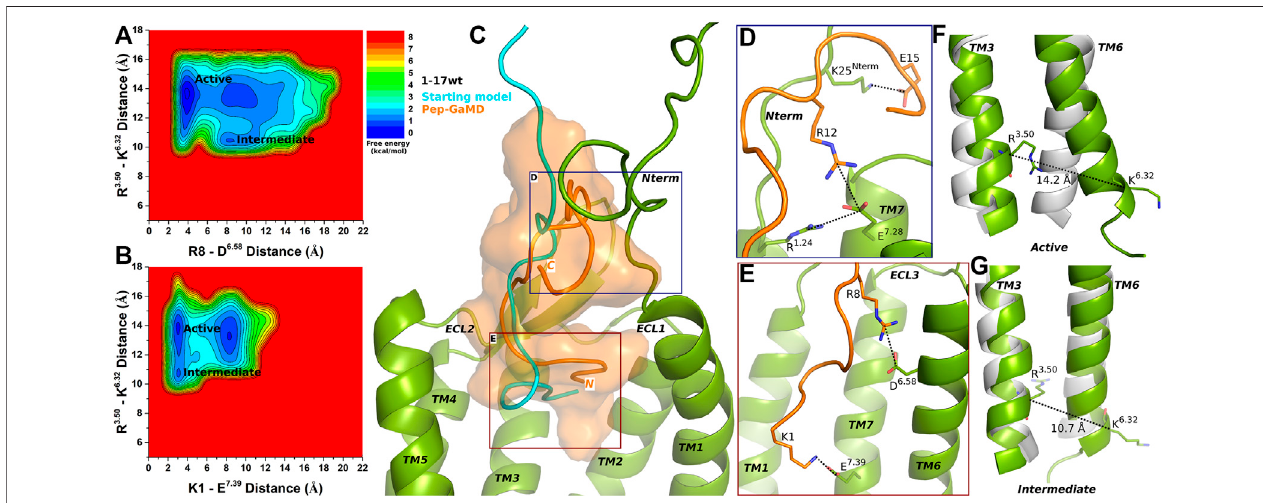
FIGURE 2 | 1 – 17 wt peptide (weak agonist) bound CXCR4 sampled Active and Intermediate low-energy states. (A – B) Free energy pro fi les of CXCR4-1 – 17wt interactions calculated regarding the distance between the C α atoms of R 3.50 and K 6.32 and (A) distance between charge centers of peptide residue R8 (the CZ atom) and receptor residue D 6.58 (the CG atom), (B) distance between charge centers of peptide residue K1 (the NZ atom) and receptor residue E 7.39 (the CD atom). (C) Comparison of the top-ranked structural cluster of the 1 – 17wt peptide (weak agonist) obtained from Pep-GaMD simulations (orange cartoon) with the starting computational model (cyan cartoon). (D – E) Important residue interactions between the peptide (orange sticks) and receptor (green sticks) observed in the Pep-GaMD simulations. (F – G) The TM3-TM6 distance between the C α atoms of R 3.50 and K 6.32 as observed in the (F) Active and the (G) Intermediate